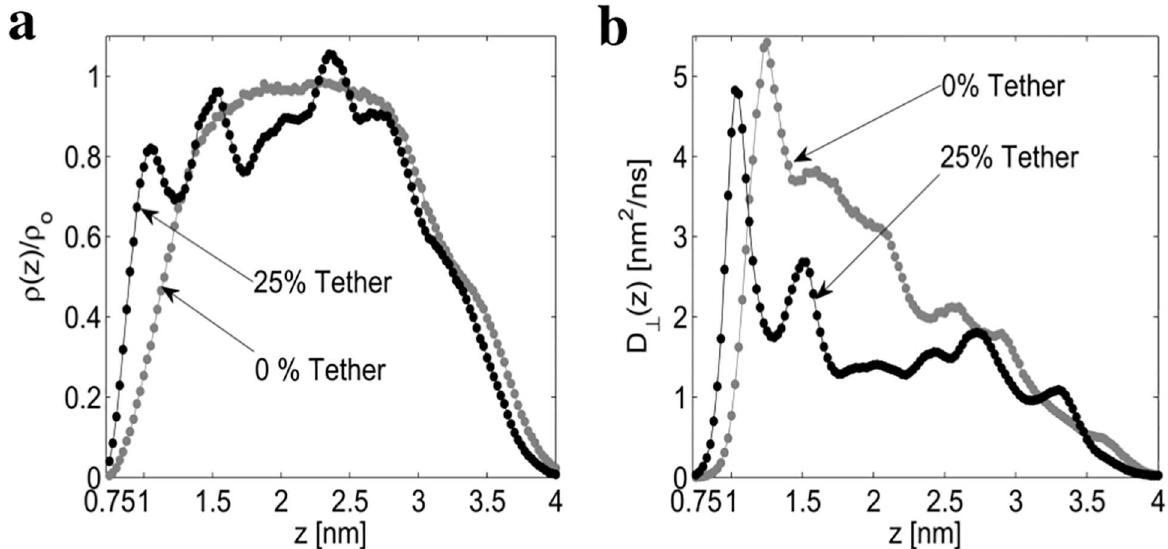
Fig 2. Normalized water density and perpendicular diffusion D ? ( z ). The normalized density ρ ( z )/ ρ o (a) and perpendicular diffusion coefficient D ? ( z ) (b) are computed from the CGMD bead trajectories.